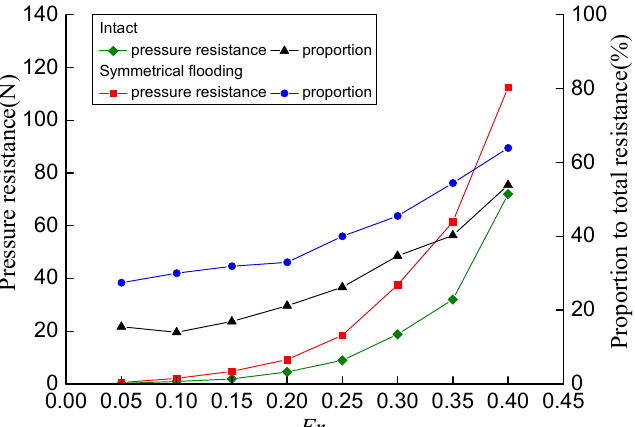
Figure 12. Comparison of frictional resistance and its proportion to total resistance for the ship in intact and symmetrical flooding cases.